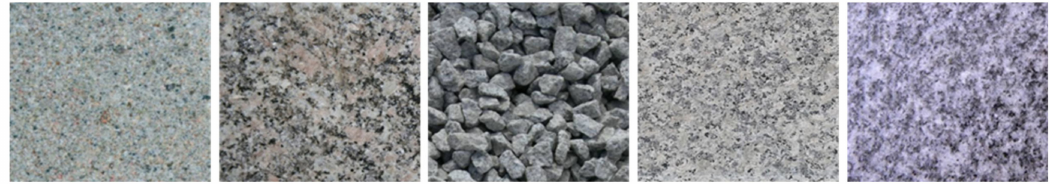
Figure 1. Successively: Izerski Granite, Karkonosze Granite, Siedlimowice Granite, Strzegom Granite, Strzelin Granite.